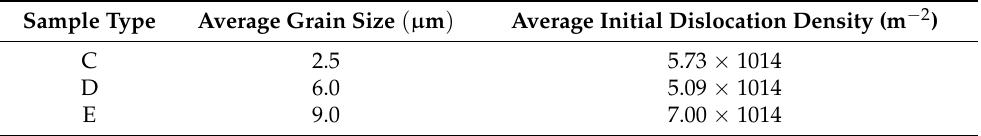
Table 1. Numerical model input parameters obtained from the DMLS Ti6Al4V (ELI) microstructures.